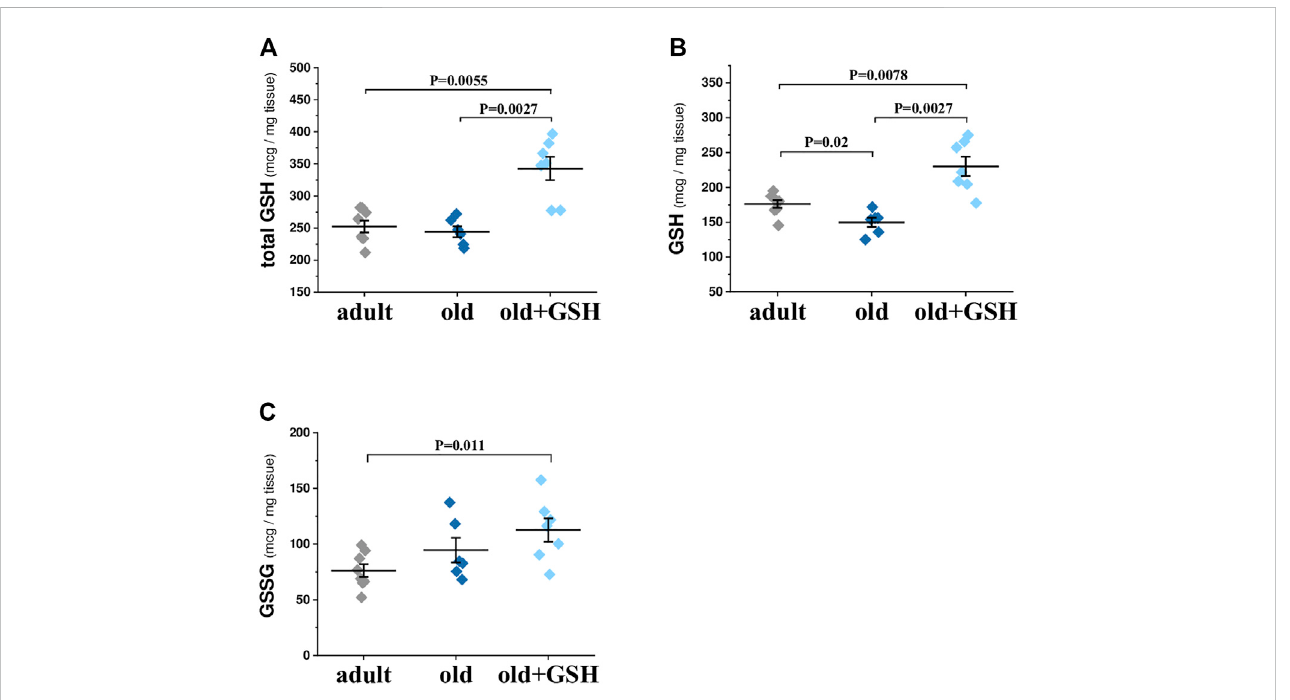
FIGURE 1 Levels of total (A) , reduced (B) and oxidized (C) glutathione in the heart tissue of adult, old and glutathione-treated old rats. GSH, glutathione. Data are represented as mean ± SEM; n = 7 – 8. Indicated p values were calculated by Kruskal-Wallis test.